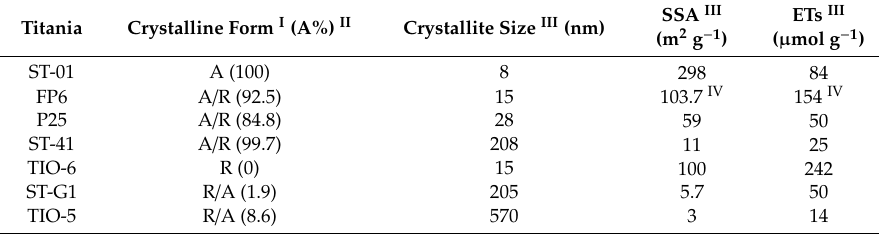
Table 1. The characteristics of commercial titania